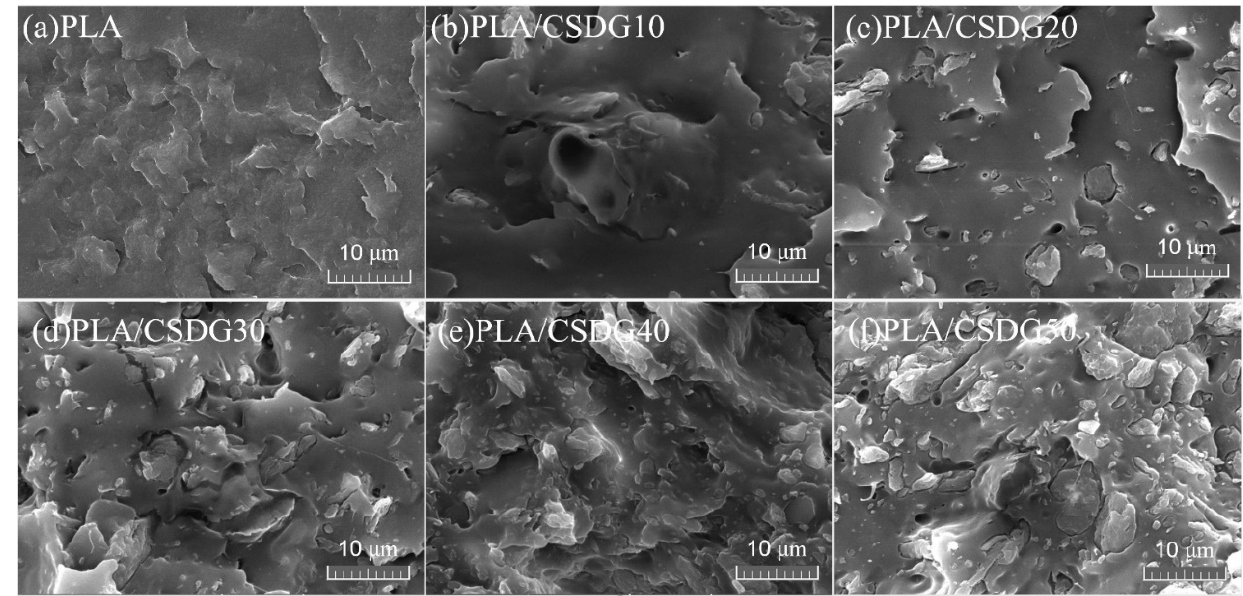
Figure 4. SEM images of PLA and PLA/CSDG composites: ( a ) PLA; ( b ) PLA/CSDG10; ( c ) PLA/CSDG20; ( d ) PLA/CSDG30; ( e ) PLA/CSDG40; ( f ) PLA/CSDG50.